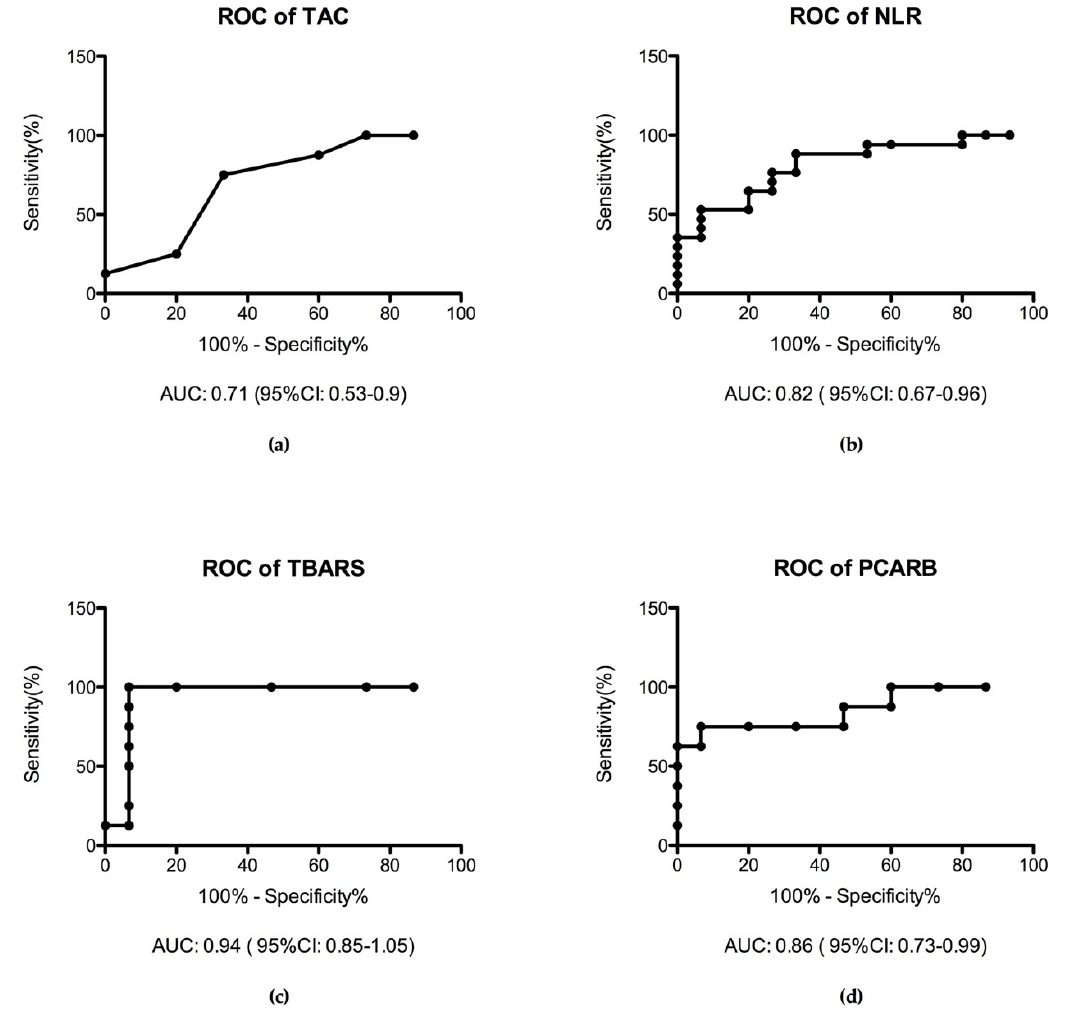
Figure 5. ROC analysis of inflammation marker NLR and oxidative stress marker in plasma: ( a ) TAC assay characteristics in MS (AUC = 0.71); ( b ) NLR characteristics (AUC = 0.82); ( c ) TBARS specificity (AUC = 0.94); ( d ) PCARB assay performance (AUC = 0.86).